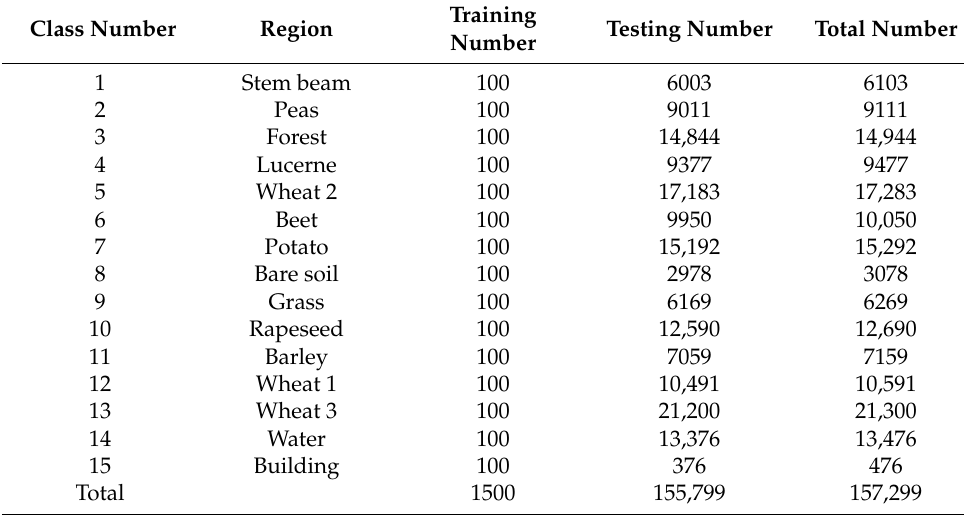
Table 1. Trainingand testing samples of the Flevoland-15 dataset.